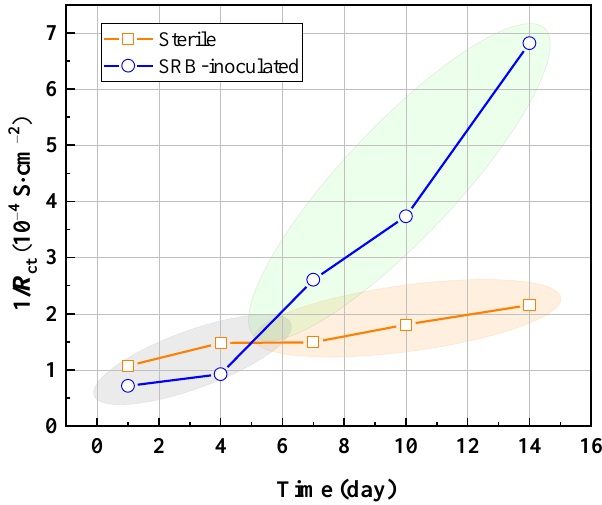
Figure 11. 1/ R ct value of specimen in the abiotic and inoculated soil solutions as a function of time.